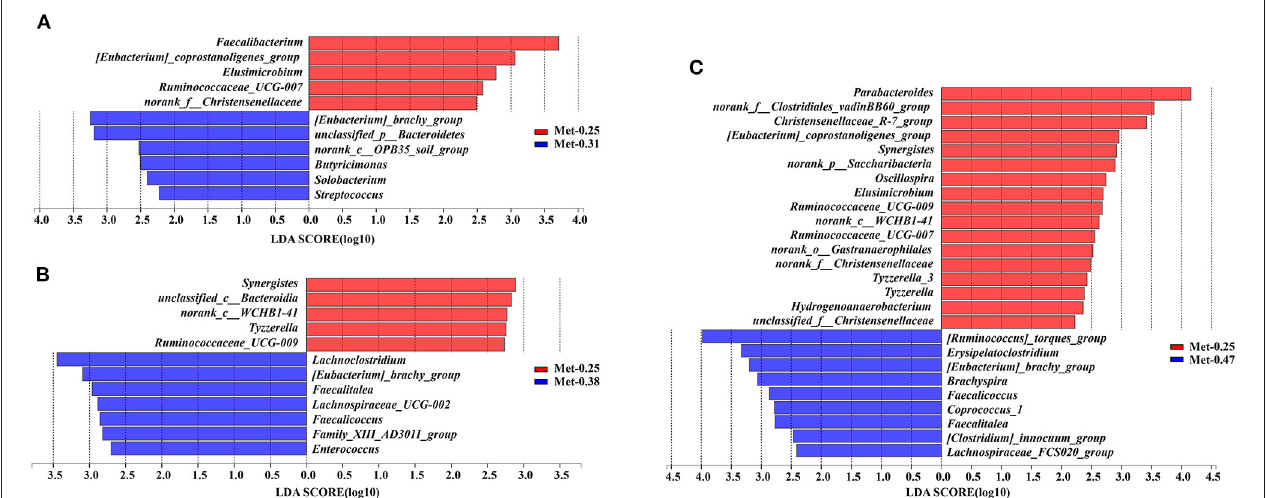
FIGURE 3 | Differentially abundant genera in the gut microbiota of laying hens between the groups supplemented with different levels of Met. Histograms of the (linear discriminate analysis) LDA score (threshold ≥ 2) are plotted. An LDA effect size (LEfSe) was performed to determine the difference in abundance ( n = 9 per group). (A) The LEfSe analysis of the gut microbiota in the 0.25 and 0.31% Met groups. (B) The LEfSe analysis of the gut microbiota in the 0.25 and 0.38% Met groups. (C) The LEfSe analysis of the gut microbiota in the 0.25 and 0.47% Met